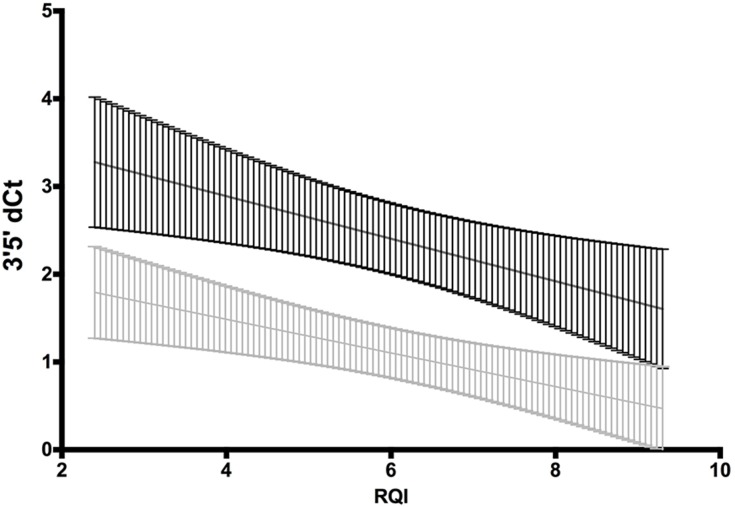
3’5’ dCt ratio of 2 housekeeping genes versus RNA RQI values.3’5’ dCt RT-qPCR ratio of TBP (black) and B2M (gray) housekeeping gene measured in adenocarcinomatous samples. The ratio is inversely correlated to the RNA integrity assessed by the RQI.